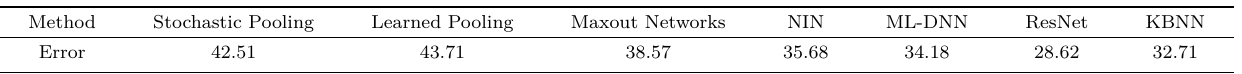
Table 4 Classification errors (%) on